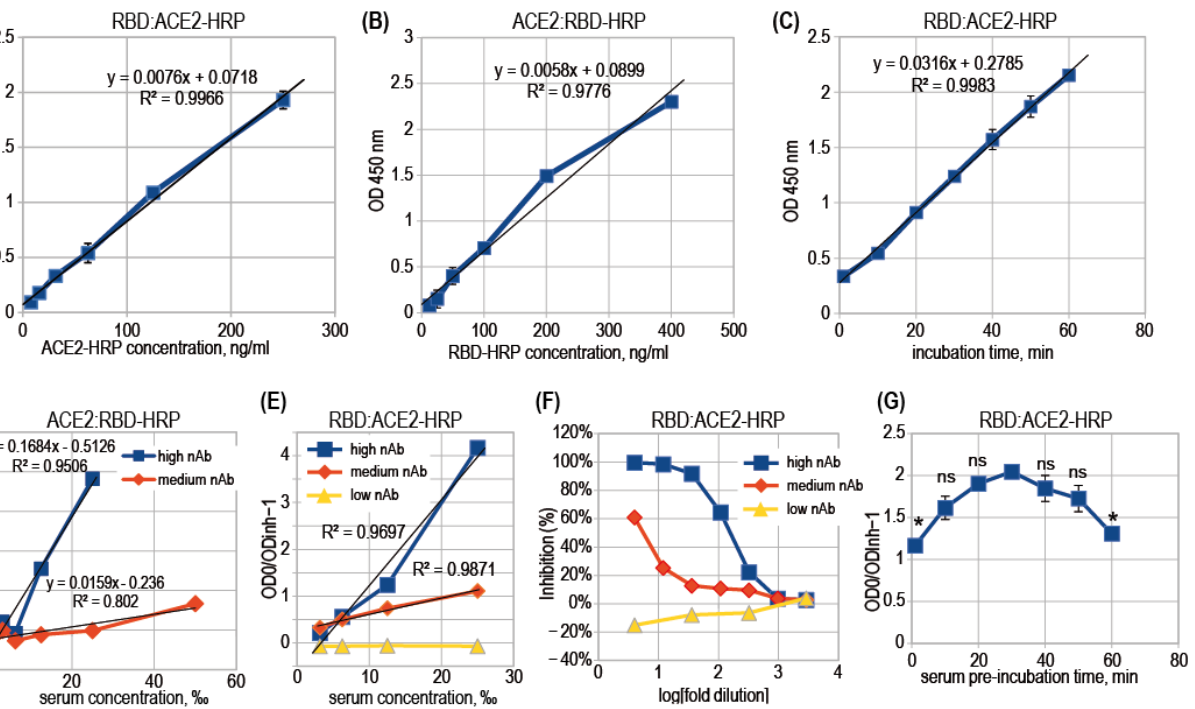
Figure 3. Performance comparison of two sVNT designs. The test design used is stated above for each figure’s panel. ( A ) Binding curve of the ACE2-HRP probe to the immobilized RBD, 30 min probe incubation time. ( B ) Binding curve of the RBD2-HRP probe to the immobilized ACE2, 60 min probe incubation time. ( C ) Kinetics of the complex formation between immobilized RBD and ACE2-HRP, ACE2-HRP concentration 400 ng/mL. ( D ) Inhibition curve shape for two serum samples with high and medium levels of nAb, immobilized ACE2. ( E ) Inhibition curve shape for three serum samples with high, medium, and low levels of nAb, immobilized RBD. High nAb—donor with the VNT threshold dilution 1280×; medium nAb—threshold dilution 20×, low nAb—no inhibition in the VNT. ( F ) Inhibition curve shape in logarithmic x -axis and inhibition percent as y. Lack of linear shape. ( G ) Variation in the observed degree of inhibition for one serum sample and various lengths of pre-incubation of test serum sample in microplate before the addition of the ACE2-HRP probe, unpaired two-sided t -test analysis, all data points versus 30 min pre-incubation, n = 2, * p < 0.05, ns— p > 0.05.